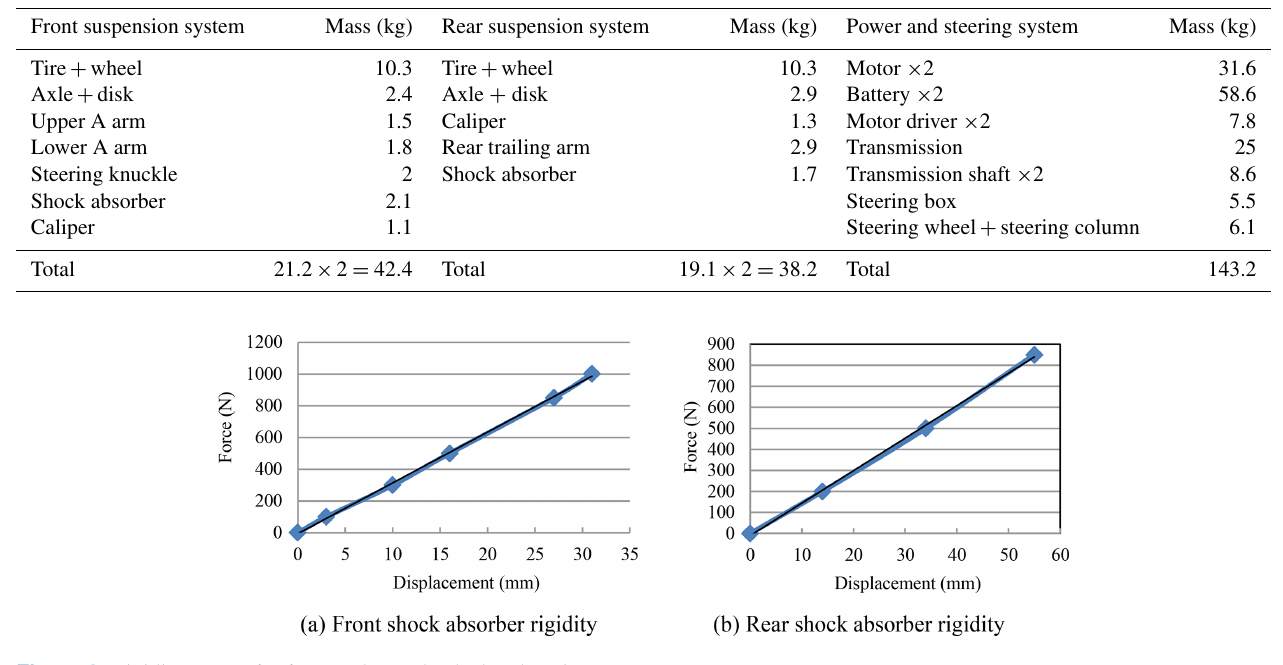
Figure 3. Rigidity curves for front and rear shock absorbers in EV.